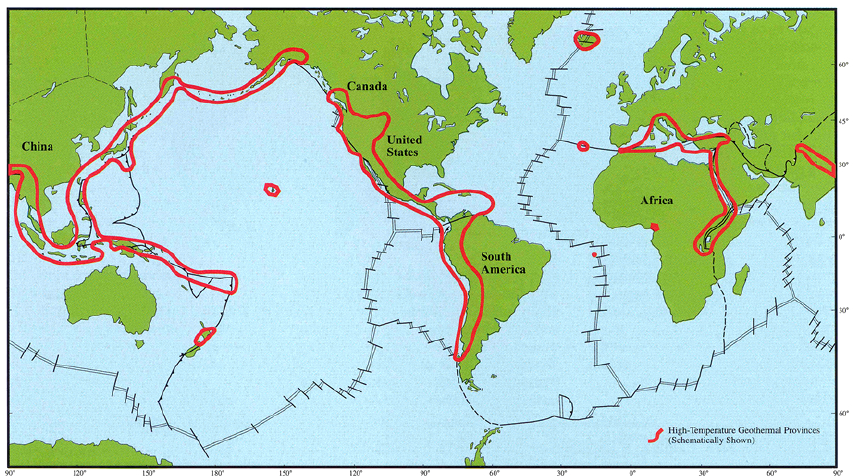
Figure 4. Outlined in red are the worldwide zones where very high enthalpy, possibly supercritical geothermal resources could exist at drillable